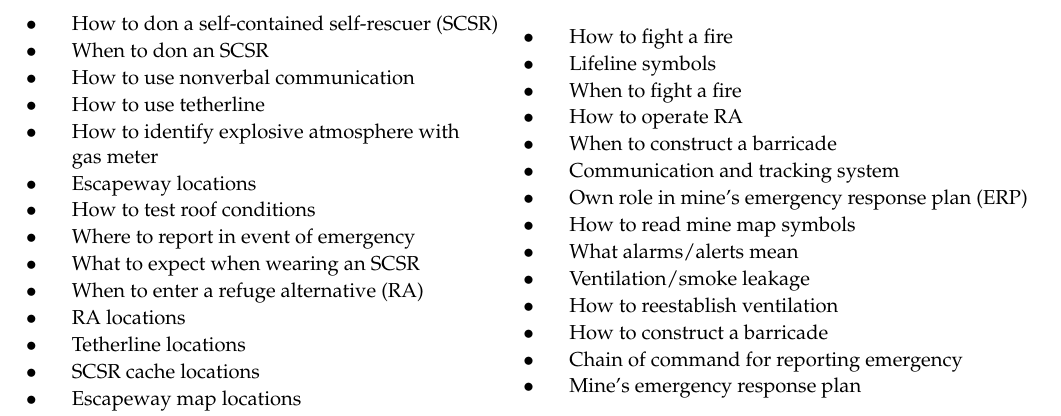
Table 2. Self-escape competency items contained in case study 2 survey.